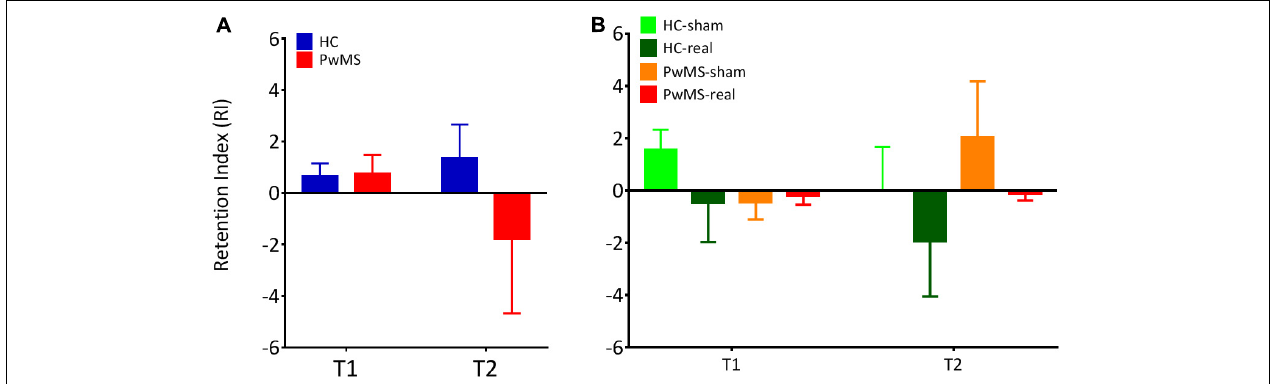
FIGURE 3 | The retention index was calculated for T1 and T2 following the first training session. This value is defined as the ratio of the average gaitline length symmetry in the early adaptation (EA) at the respective day to the average gaitline length symmetry in the late adaptation phase (LA) of the previous day. (A) Retention index for experiment 1 without tDCS ( N = 10 per group). (B) Retention index for experiment 2 with tDCS ( N HC − sham = 9, N HC − real = 11, N PwMS − sham = 15, N PwMS − real = 15). Error bars represent the standard error of means.